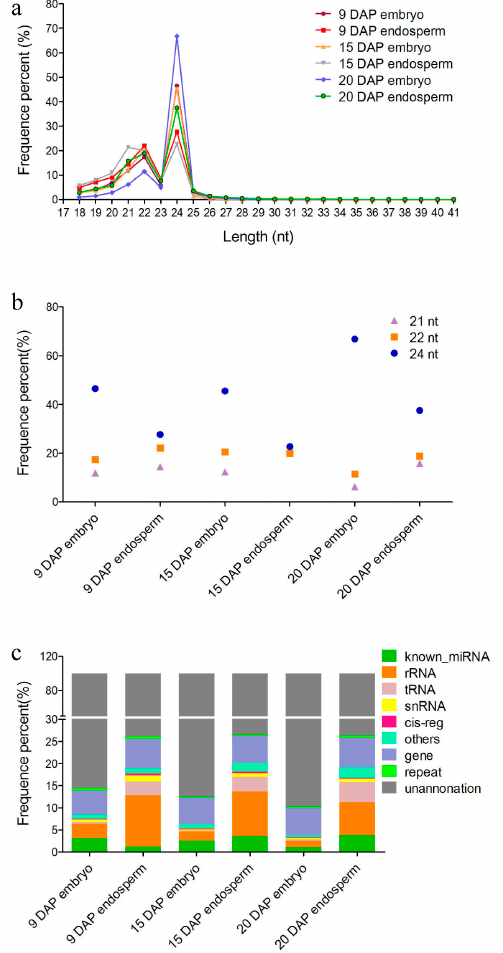
Figure 1. Overall small RNAs (sRNAs) dynamics during the maize kernel development process. ( a ) Line charts showing the length-distribution of total sRNAs from six deep sequenced libraries at different maize kernel development stages. ( b ) Dot chart showing different percentages of the 24-nt, 22-nt and 21-nt total sRNAs presenting in the embryo and endosperm at different kernel development stages. ( c ) Bar graph showing the sRNA dynamics of different categories from the six libraries of different tissues and development stages. rRNA: ribosomal RNA; tRNA: transfer RNA; snRNA: small nuclear RNA.